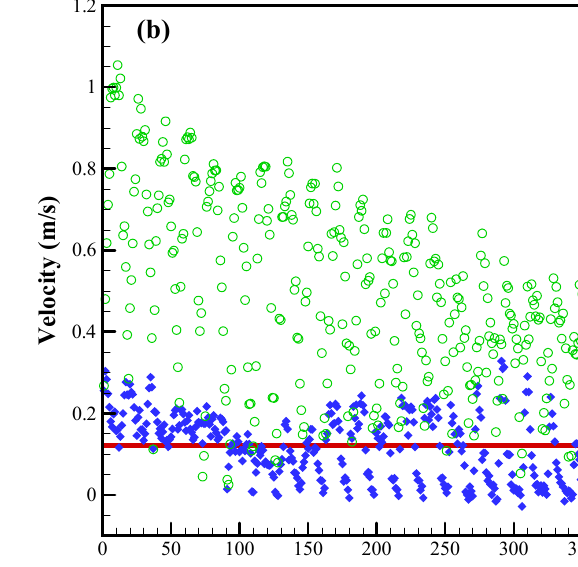
Number of Velocity